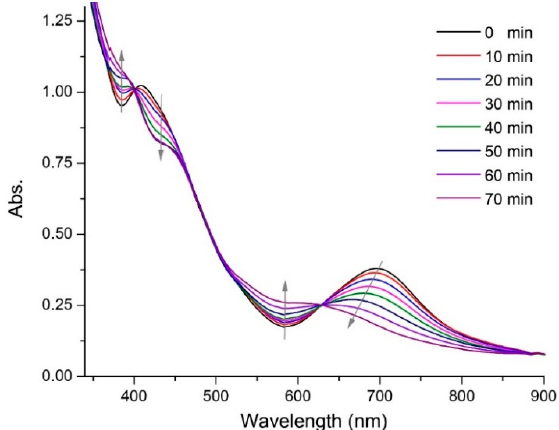
Figure 2. Time ‐ dependent UV ‐ Vis spectra of the Ag 2 Au 25 (SR) 18 nanocluster reacting with PET ligands in dichloromethane.